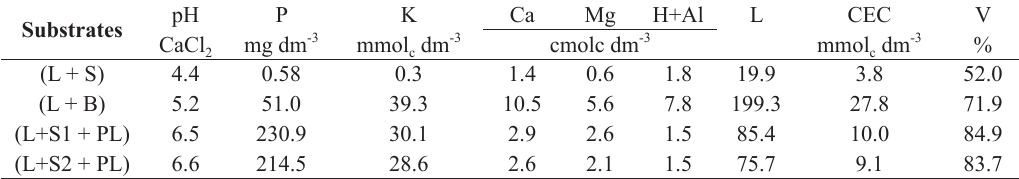
Chemical analysis of substrates for seedling emergence and uvaia seedling production ( Eugenia pyriformis